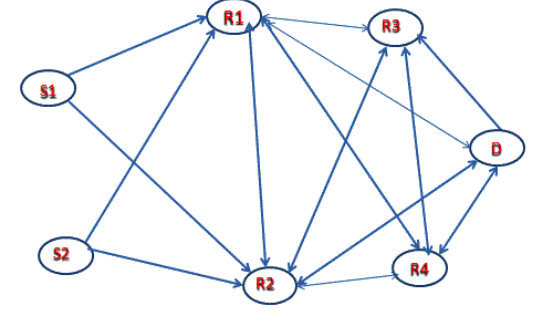
Figure 1. Two and three hop relay